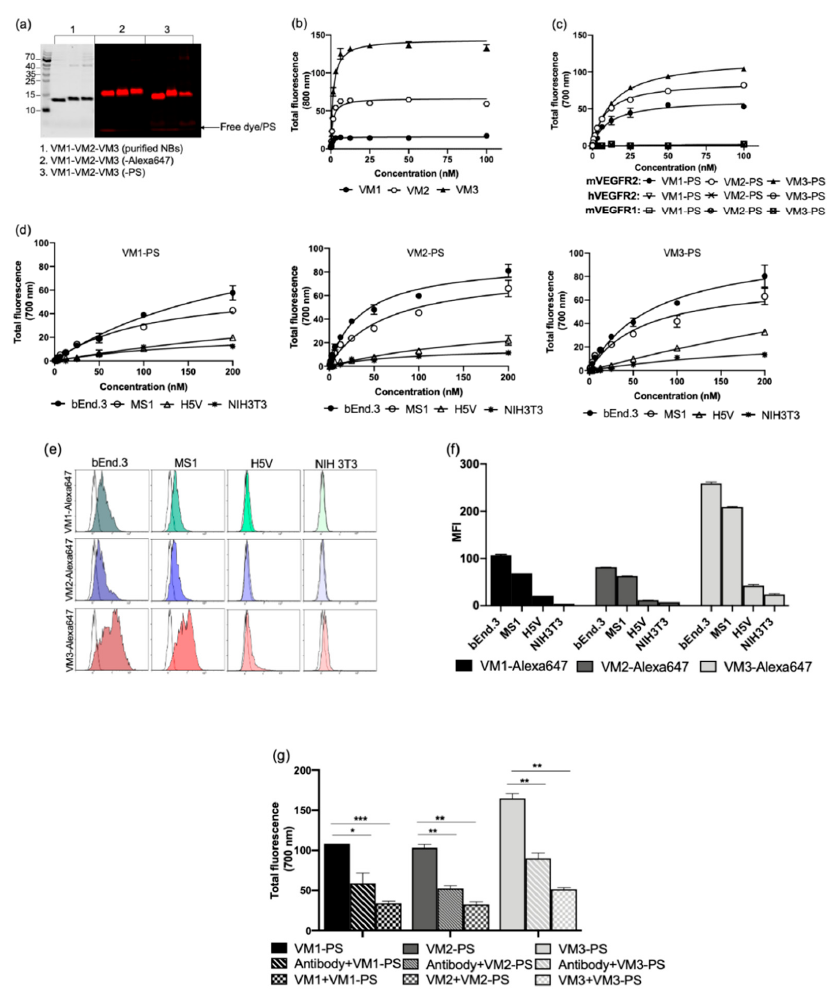
Figure 1. Purity and specificity of the NBs and NB–conjugates. ( a ) Purified NBs, NB–Alexa647, and NB–PS conjugates separated by SDS-PAGE. Free dye/PS is observed at the gel front (arrow): (1) purified NBs after PageBlue staining (depicted in black); and (2,3) the fluorescence of Alexa647 and PS detected at 700 nm, respectively (depicted in red). ( b ) Binding of the unlabeled NBs to the mVEGFR2 protein detected by anti-VHH antibody. ( c ) Binding of the NB–PS conjugates to the mVEGFR2, hVEGFR2, and mVEGFR1 proteins. Total fluorescence of NB–PS bound to the protein was detected using an Odyssey infrared scanner at 700 nm. ( d ) Total fluorescence intensity of cell bound/internalized NB–PS conjugates on the murine cell lines after 1-h incubation at 37 ℃ . ( e,f ) Fluorescence of NB–Alexa647 conjugates detected by flow cytometry. The murine cell lines were incubated with the conjugates for 1 h at 37 ℃ followed by trypsinization and FACS analysis. Mean fluorescent intensity (MFI) obtained from flow cytometry. Data are shown as mean ± SD. ( g ) In vitro competition experiments of the NB–PS conjugates tested on bEnd.3 cells in the presence or absence of ten-times excess of anti-VEGFR2 antibody or unconjugated NBs. Total fluorescence intensity of the associated NB–PS conjugates was detected by an Odyssey infrared scanner at 700 nm (* p < 0.05; ** p < 0.01; *** p < 0.001; t -test).